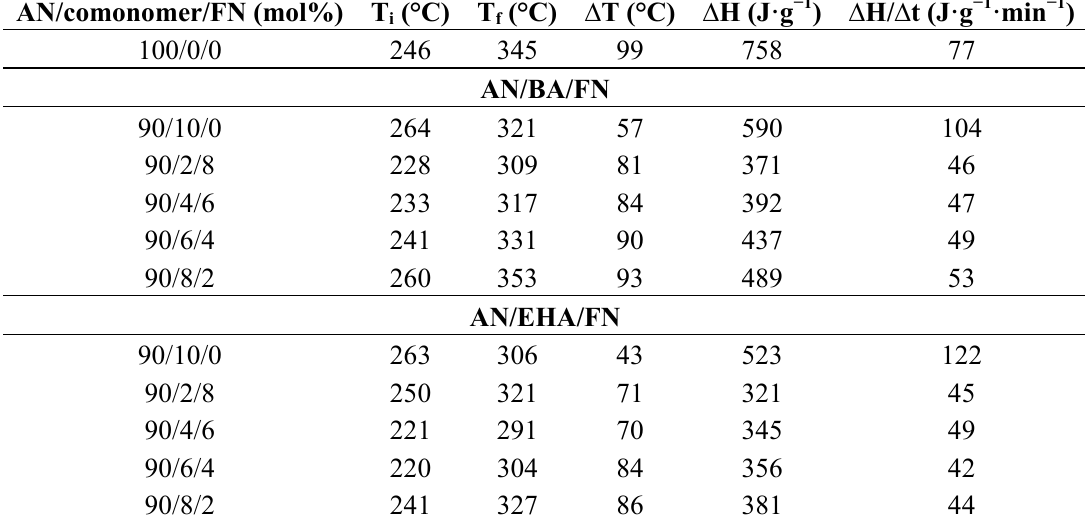
Table 3. DSC data of PAN homopolymer, copolymers and